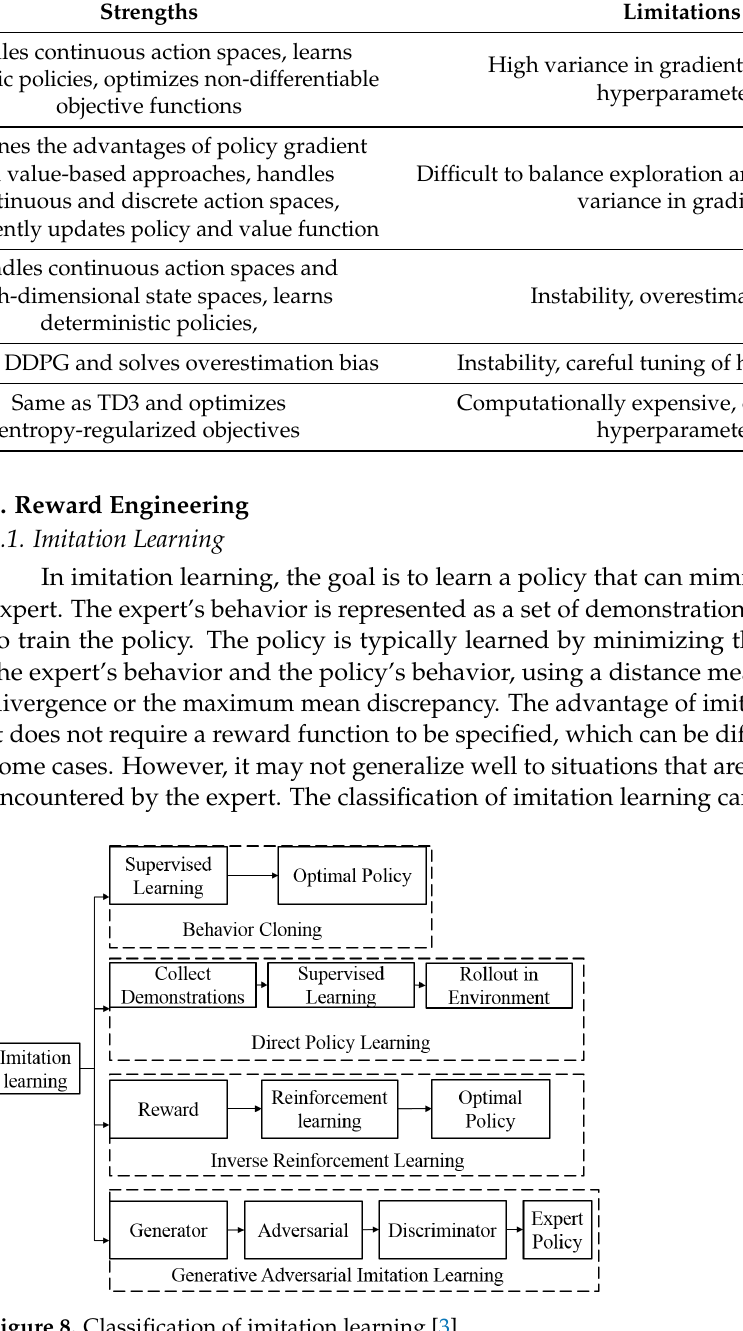
Figure 8. Classification of imitation learning